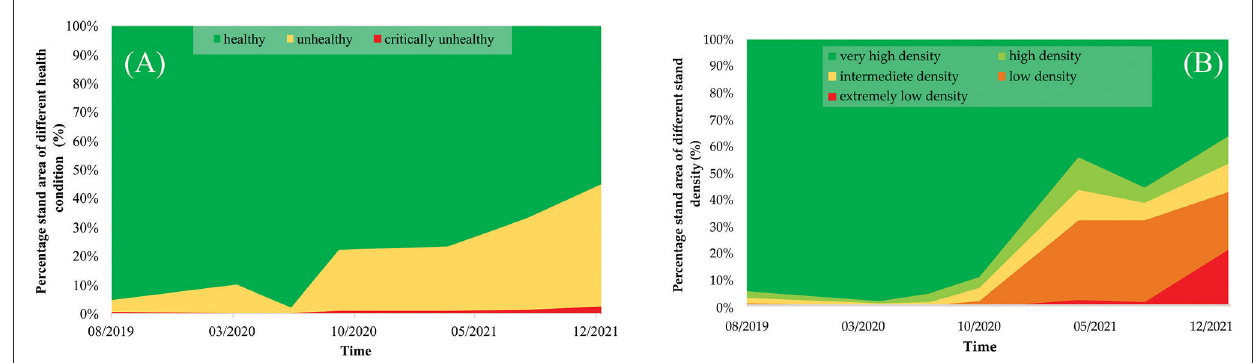
FIGURE6 Accumulated areas of mangrove stand based on (A) the stand health condition from the PSRI analysis and (B) the stand density from the NDVI analysis of the mangrove ecosystem in East Lampung in August 2019–January 2022.